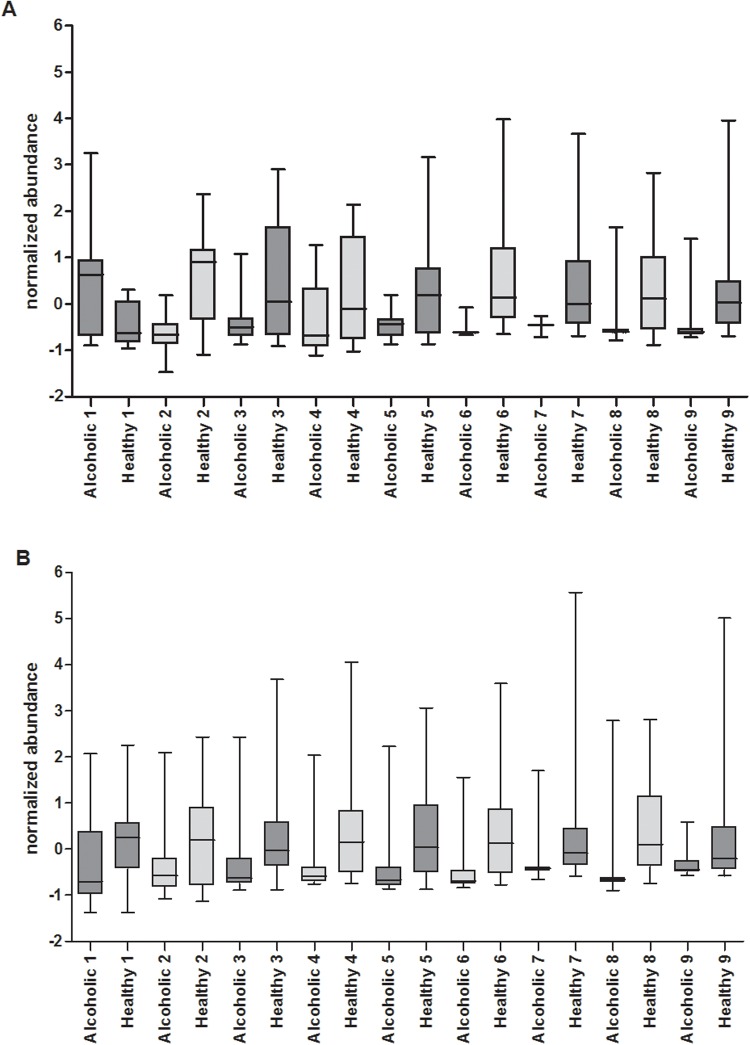
Metabolites with a statistically significant difference in median abundance levels.The metabolites listed in Table 2 were compared among the healthy and alcoholic cohorts. Box plots are shown, depicting the interquartile range of Z-score normalized abundance values, with whiskers extending from minimum to maximum. The median value is identified by a horizontal line within the box. Metabolites from the endoscopy collected samples are shown in A), and are numerically coded as follows; 1) tetradecane, 2) 2-tetradecen-1-ol, 3) 1-undecanol, 4) propanoic acid, 5) cyclopropane, nonyl-, 6) 6-pentadecen-1-ol, 7) 8-Tetradecen-1-yl acetate, 8) 1,15-Pentadecanediol, and 9) Eicosen-1-ol. Metabolites from the home collected samples are shown in B), and are numerically coded as follows; 1) caryophyllene, 2) 1-naphthalenol, 3) phellandrene, 4) dimethyl disulfide, 5) dimethyl trisulfide, 6) camphene, 7) 2,5-pyrrolidinedione, 1-(benzoyloxy)-, 8) 5-hepten-2-one, 6-methyl-, and 9) (2-aziridinylethyl)amine. See text for further discussion.